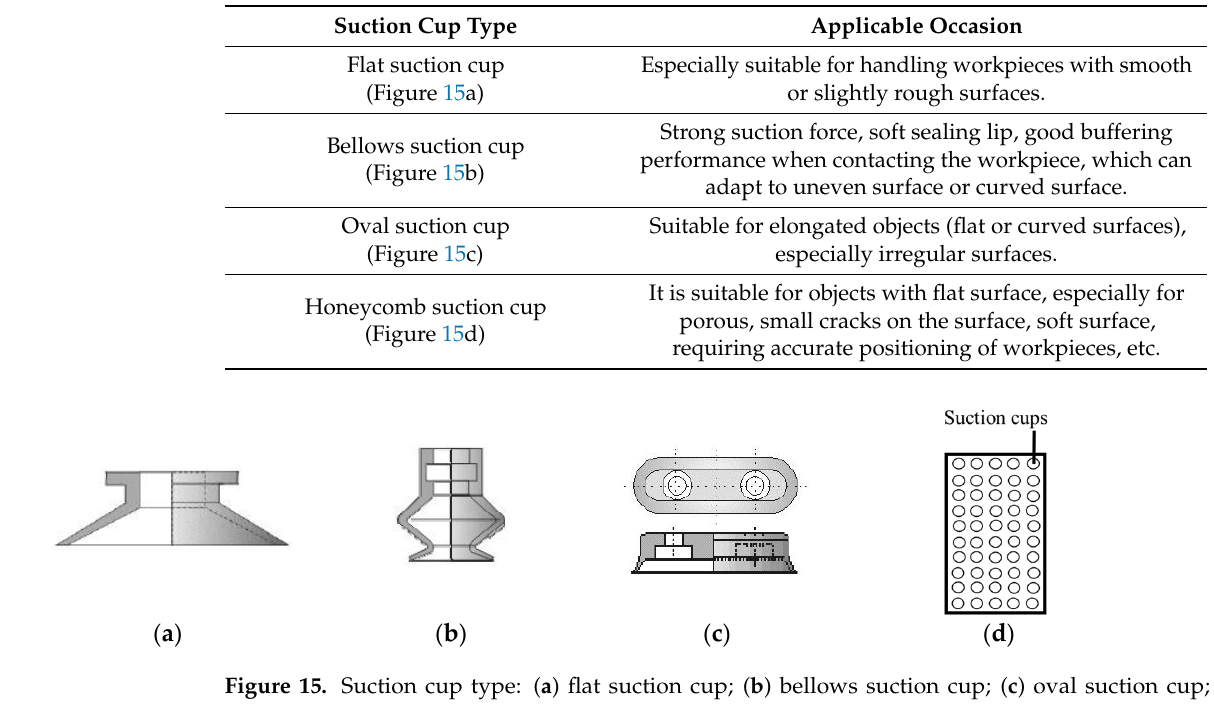
Figure 14. Apple bottom curvature.